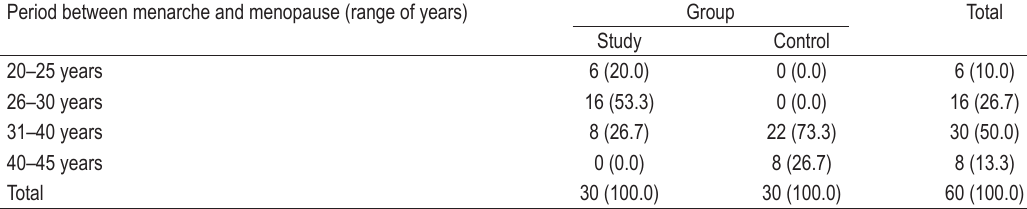
TABLE 5. Comparison of period between menarche and menopause expressed in range of years by groups Period between menarche and menopause (range of years)